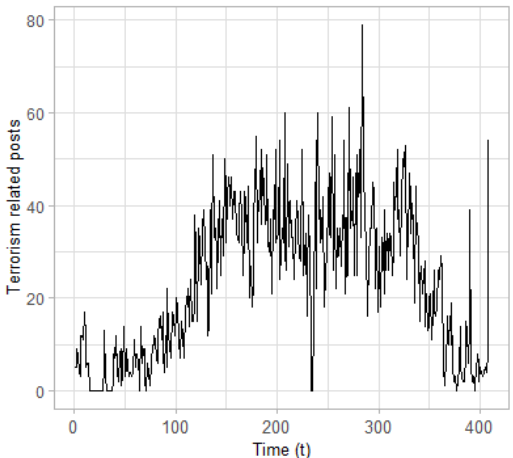
Figure 4. Time series of posts classified as terrorism related.